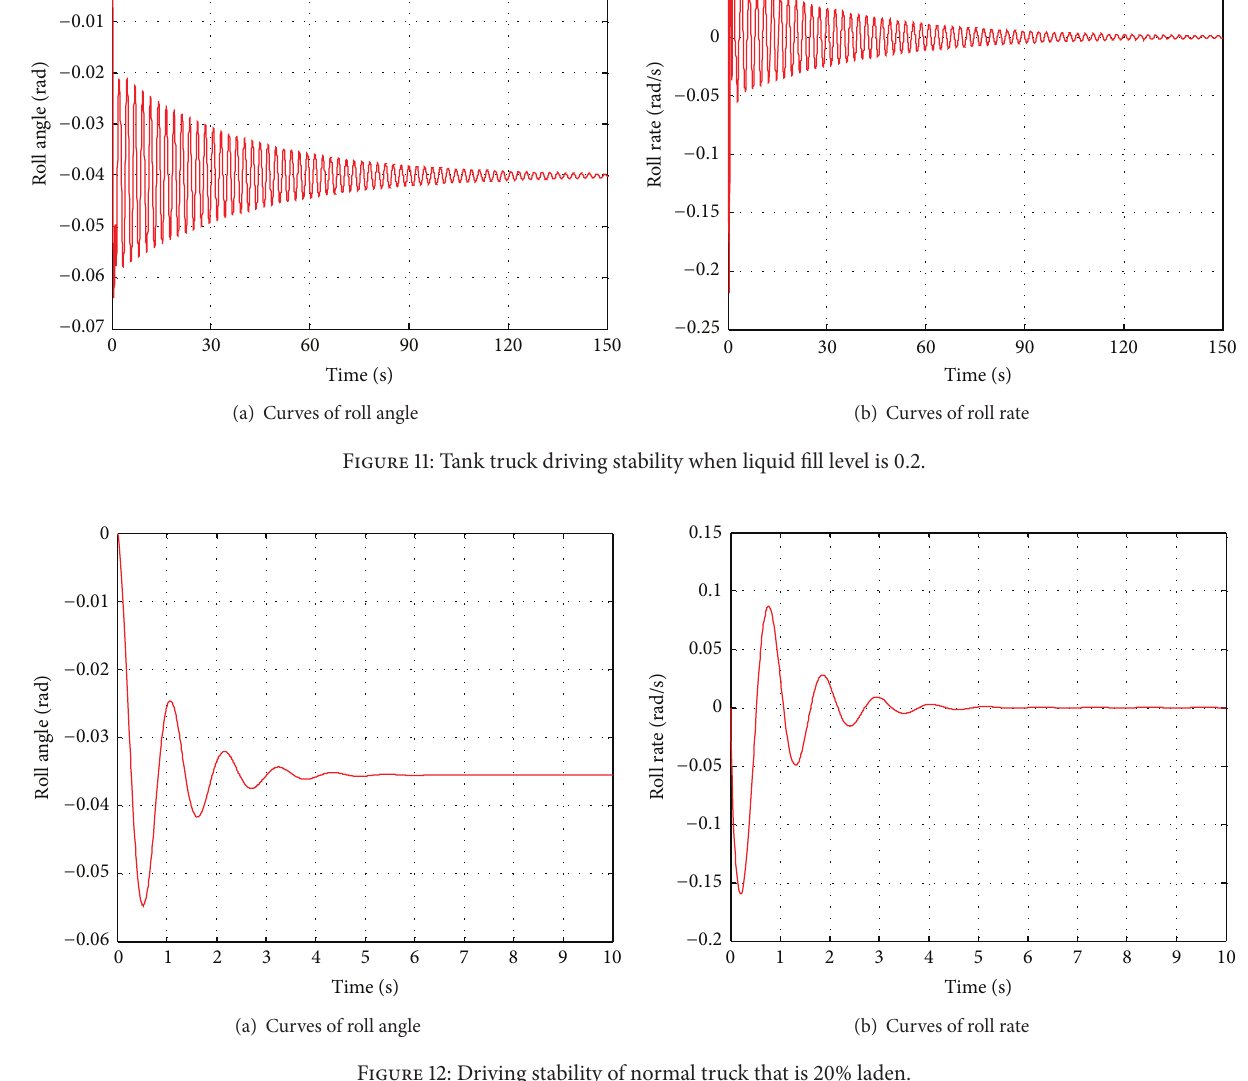
Figure 12: Driving stability of normal truck that is 20%